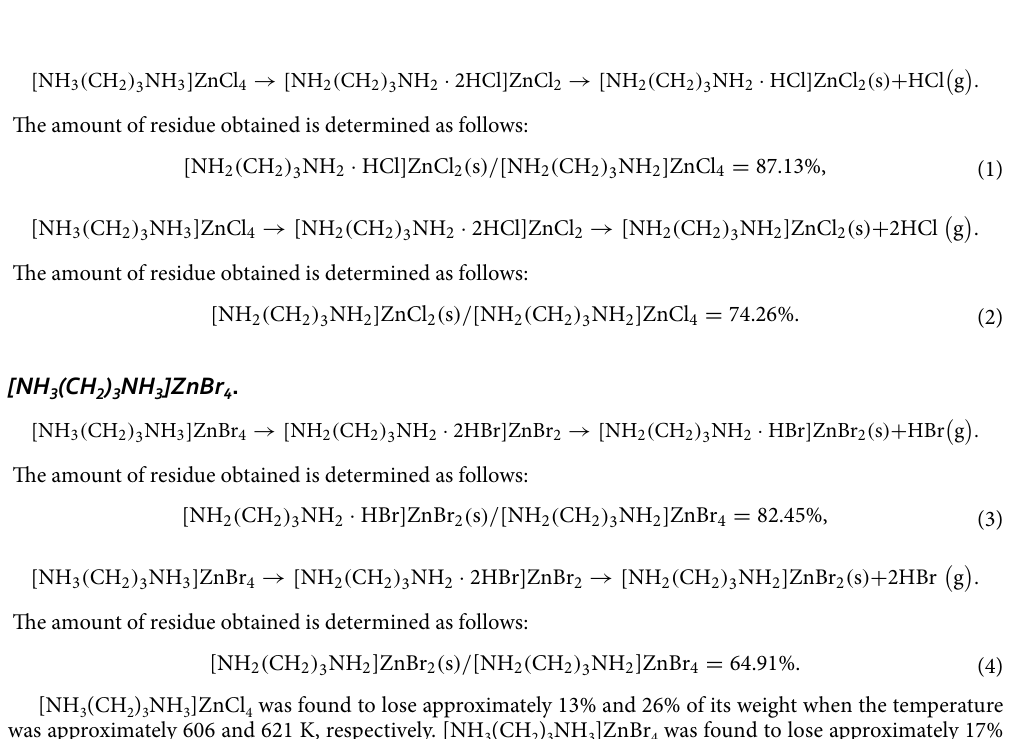
Figure 4. ( a ) Thermogravimetric analysis (TGA) and differential thermal analysis (DTA) of [NH 3 (CH 2 ) 3 NH 3 ] ZnCl 4 . ( b ). Thermogravimetric analysis (TGA) and differential thermal analysis (DTA) of [NH 3 (CH 2 ) 3 NH 3 ]